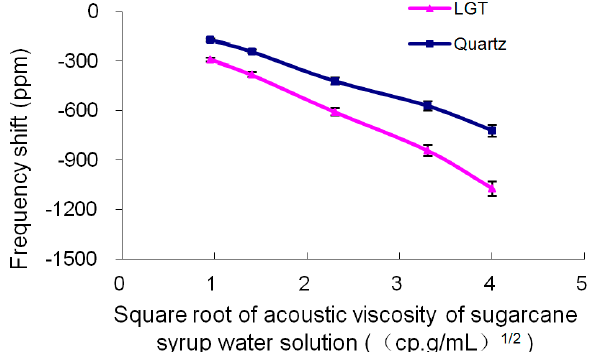
Figure 6. Frequency changes of different LFE devices for a variety of acoustic viscosities of sugarcane aqueous solutions.